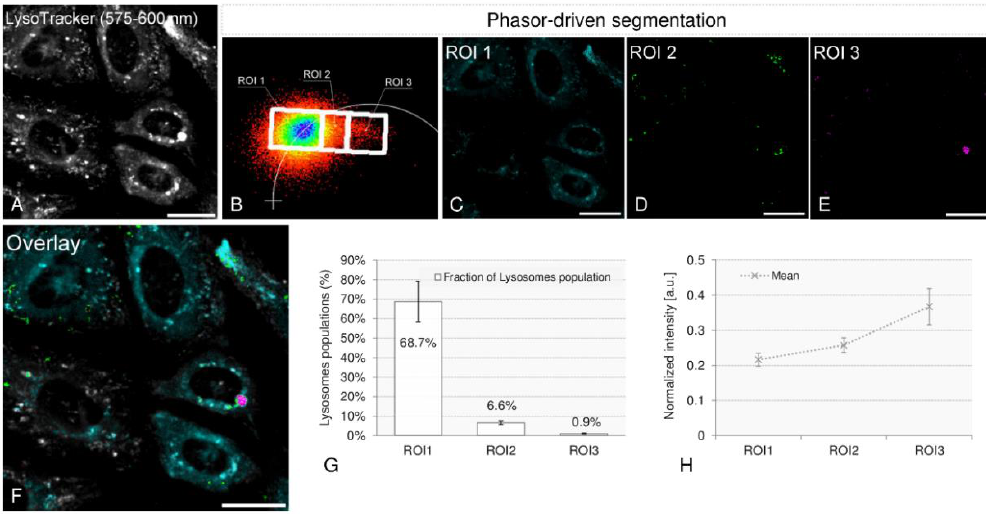
Figure 6. LysoTracker colocalization experiment: lifetime-based segmentation of lysosomes. ( A ) Mask for acid organelles obtained by integrating the LysoTracker fluorescence signal in the emission range 575–600 nm and by applying an intensity- based threshold (50 percentile of brightest pixels) to remove the background. A phasor-driven segmentation allows identifying three regions of interest, with decreasing lifetime, indicated in ( B ) as ROI 1, ROI2, and ROI 3, respectively. Phasor-driven segmentations are shown in cyan (ROI 1), green (ROI 2), and magenta (ROI 3), in ( C – E ), respectively, while the overlap is represented in ( F ). The graph in ( G ) shows the fractions, expressed as percentage, of each ROI’s pixels labeled with SG18:0. In ( H ) the normalized emission intensity of LysoTracker associated with each ROI and normalized to the fraction of bright pixels in the image is reported. Values, indicated as mean ± standard error, were evaluated on n = 25 cells.